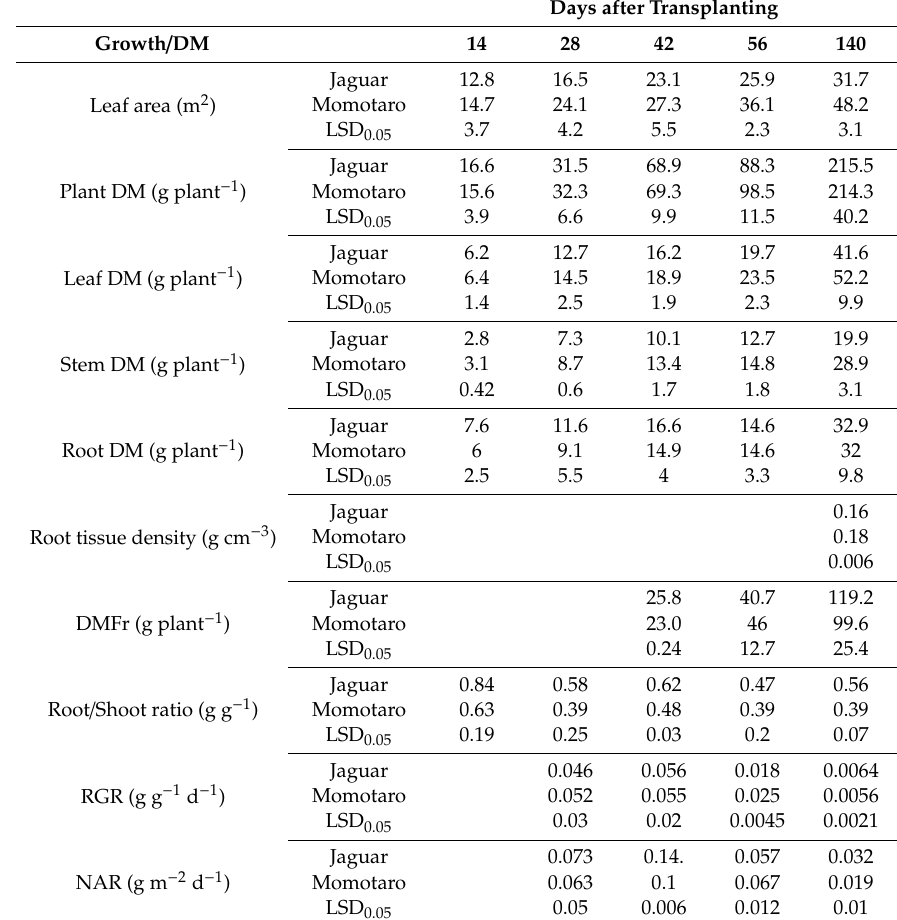
Table 4. Dry matter partitioning and growth rate of tomato as influenced by